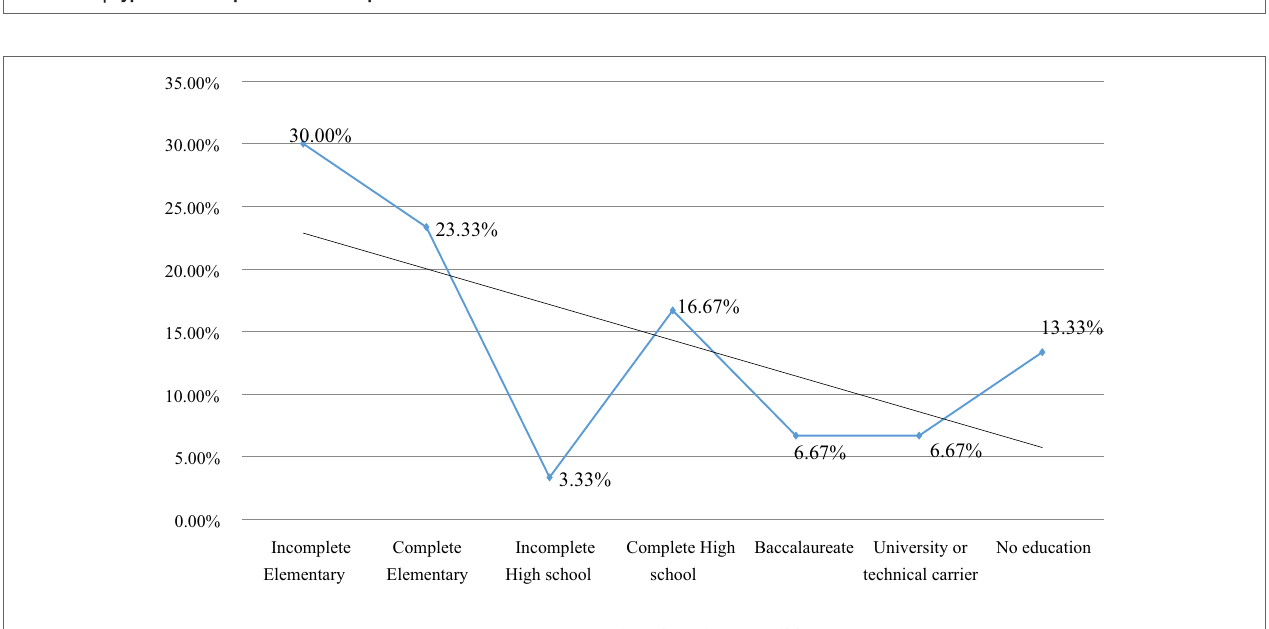
FigUre 1 | Type of health problems in the past 12 months and medical attention received